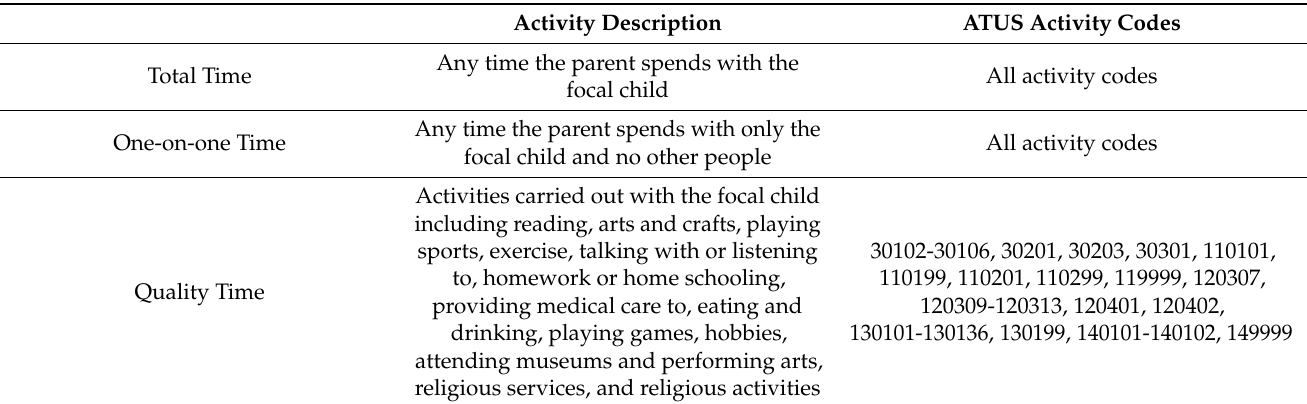
Table A1. Description of the Construction of Parental Time Investment Measures.